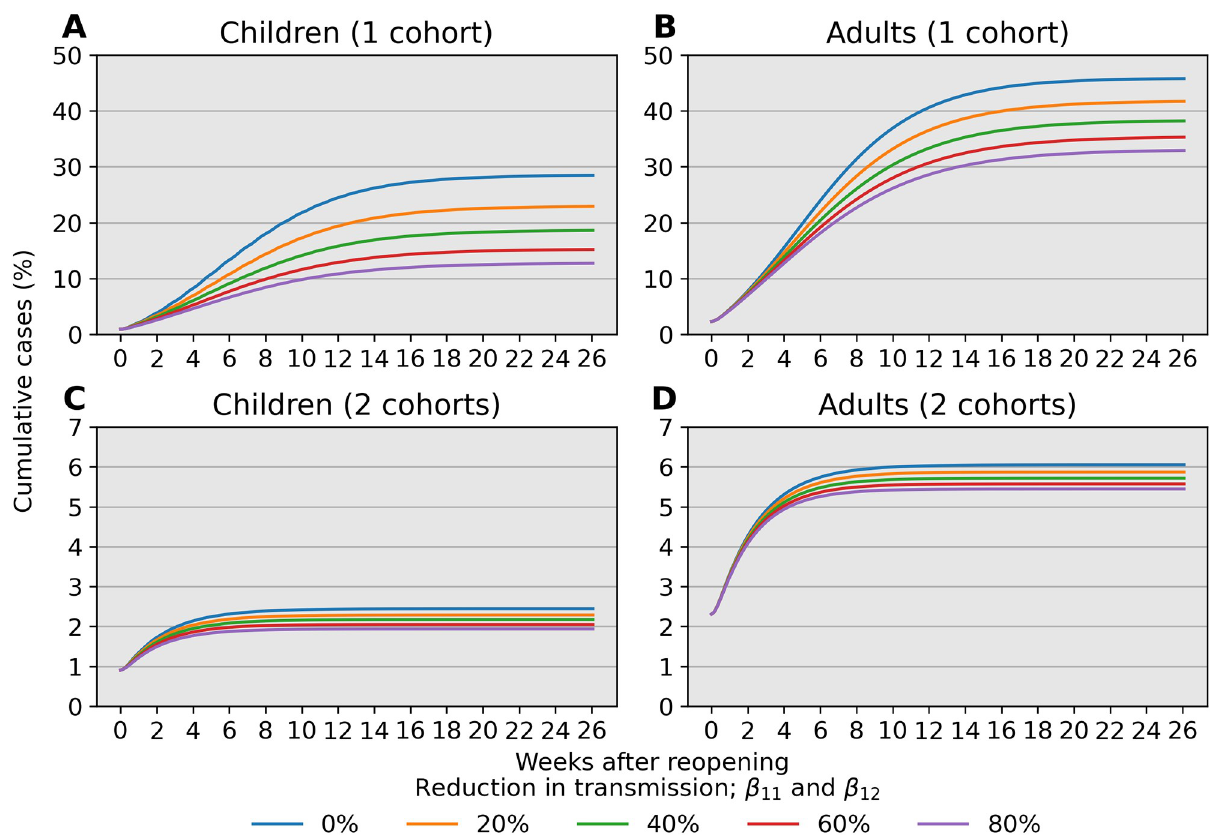
Fig 6. Cumulative prevalence trajectories under risk reduction strategies for children while at school. For child-child transmission, we set β 11 = 0.1 × (1 − r ) outside of school and β 11 = (1 #x2212; r ) × c × 0.1 during school, where r is a reduction factor due to effective risk reduction strategies and c = 10 accounts for increased contact between children. (A–B) Mitigation that reduces transmission between children can lead to a substantial reduction in infections for both children and adults, provided the mitigation effects are large. (C–D) The impact of risk reduction strategies persists when children are separated into 2 rotating cohorts but does not demand as strict an adherence to be effective. An 80% reduction in pediatric transmission has a weaker effect compared to separating children into 2 rotating cohorts as the latter strategy result in fewer than 5% pediatric infection over 26 weeks (6 months).